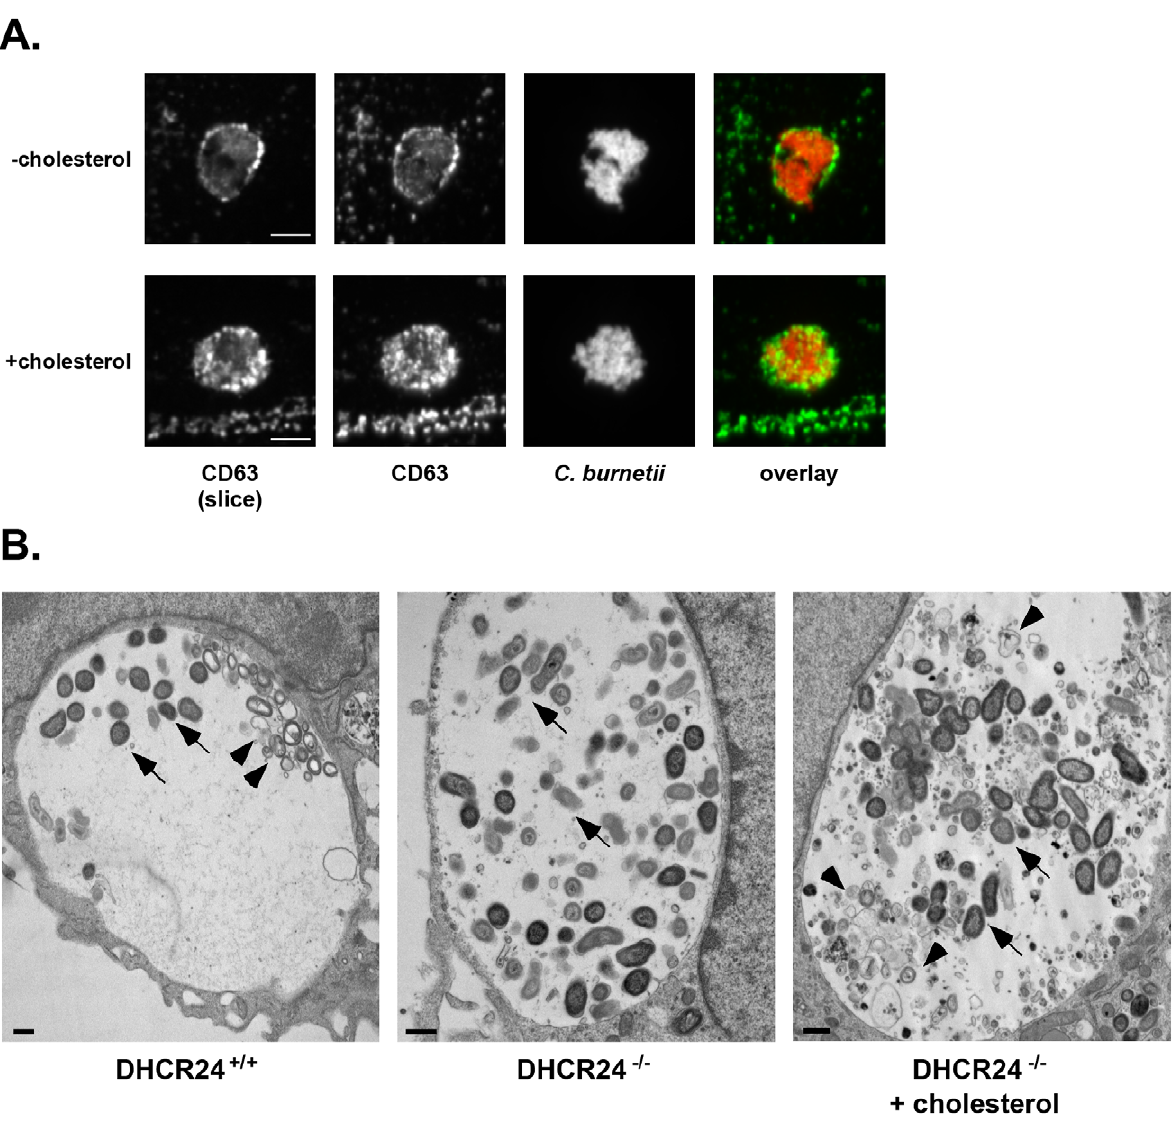
Figure 6. The lumenal contents of the C.burnetii vacuole are altered in the absence of cholesterol. (A). Fluorescence micrographs of C. burnetii -infected 2 cholesterol and + cholesterol MEFs stained for the late endosome/multivesicular body marker CD63 (green) and C. burnetii (red) at 4 dpi. Unlike + cholesterol MEFs, CD63 was not found in the lumen of vacuoles within 2 cholesterol MEFs. The first panel shows a single confocal slice through the middle of the vacuole, while the second panel is a maximum intensity Z projection of the entire vacuole. Scale bars=5 m m. (B). Transmission electron microscopy revealed multilamellar membranous structures (arrowheads) within vacuoles harboring C. burnetii (arrows) in infected DHCR24 + / + and DHCR24 2 / 2 + cholesterol MEFs, but not DHCR24 2 / 2 2 cholesterol MEFs. Scale bars=500